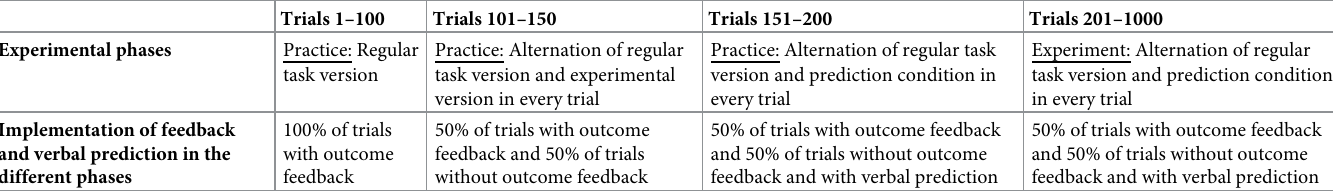
Table 1. Overview of the experimental